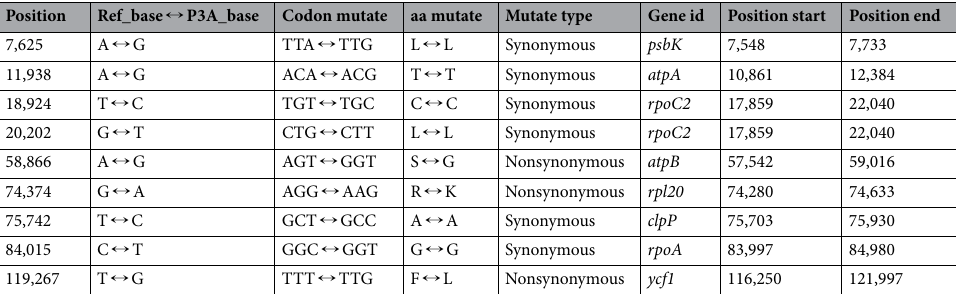
Table 2. SNPs in gene coding region of